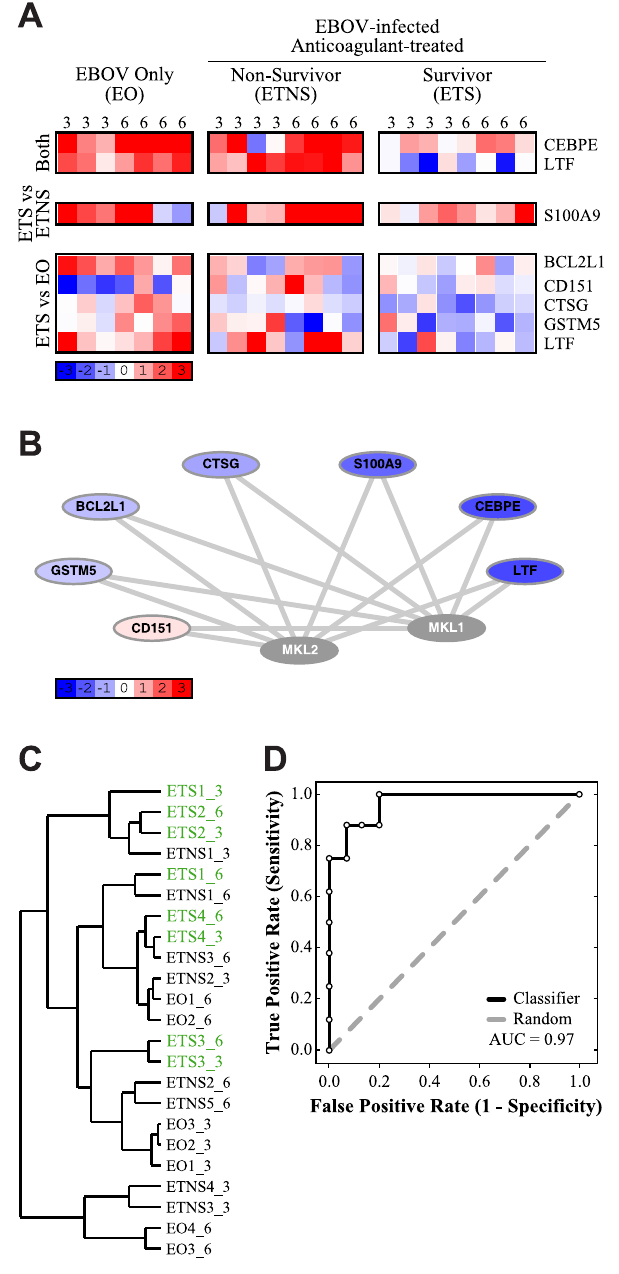
Figure 6. Megakaryoblastic leukemia 1 (MKL1) and myocardin- like protein 2 (MKL2) jointly regulate some survival-associated genes. ( A ) A heatmap depicting the gene expression values of 8 probes (7 genes) which are jointly transcriptionally regulated by MKL1 and MKL2. The days post-infection are labeled at the top of each column. Probes are grouped according to which comparison identified them, listed to the left. Gene names are listed to the right. Blue indicates down-regulation, and red indicates up-regulation, of genes compared to pre-infection baseline, white indicates no change in expression (scale indicated). ( B ) A network illustrating transcriptional connections between the 7 genes and MKL1/2. Blue indicates lower expression values in ‘‘EBOV-infected, Treated Survivors’’ (ETS), com- pared to ‘‘Non-Survivors’’ (NS), red indicates higher expression values in the ETS group compared to the NS group (scale indicated). Grey nodes ( e.g. MKL1) were not identified as being differentially expressed by our protocol. ( C ) A dendrogram depicting hierarchical clustering of individual samples, using the gene set of 7 probes. ETS samples